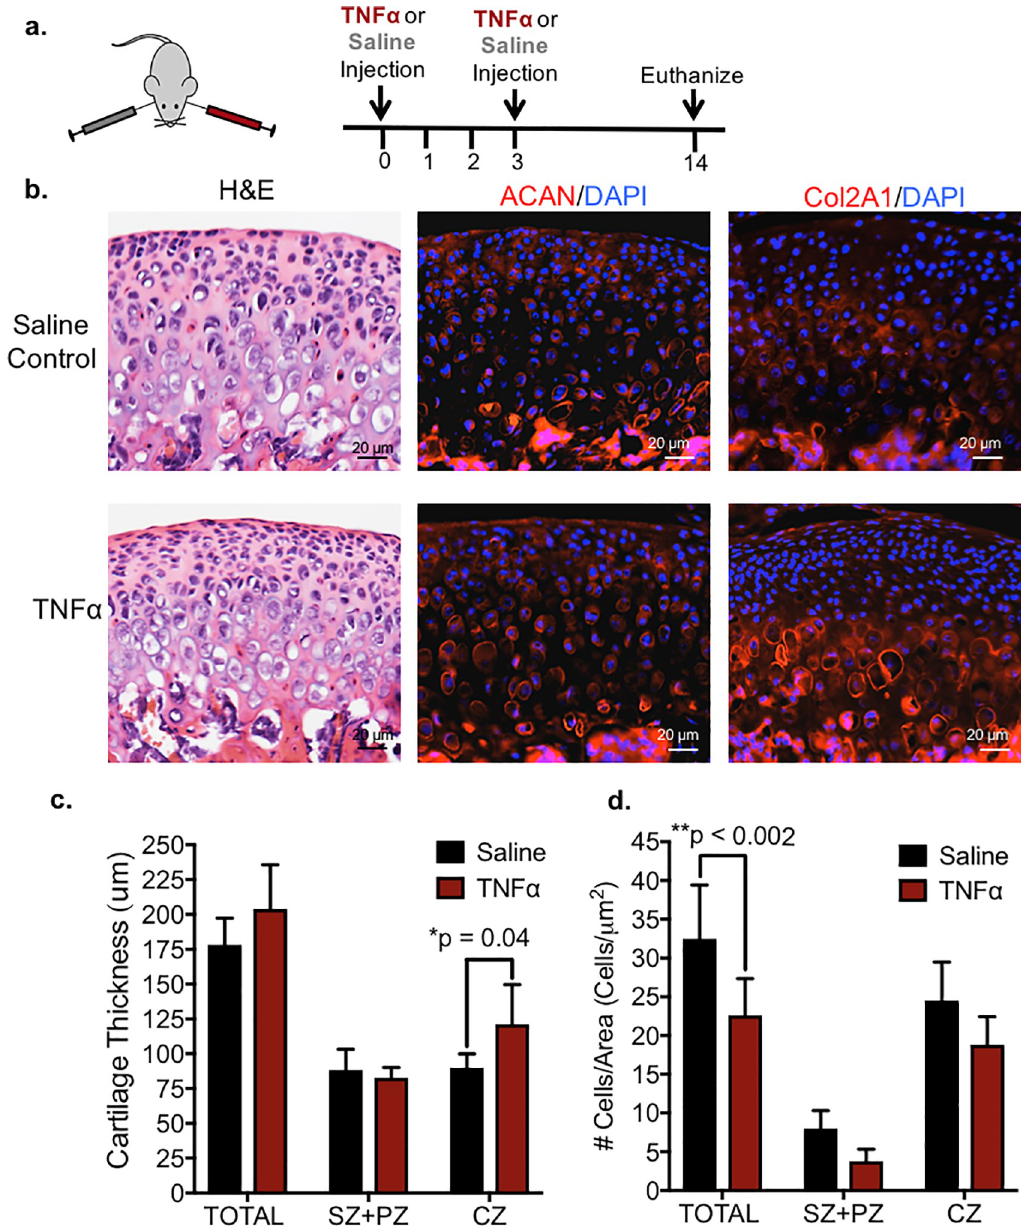
Fig 3. TMJ intra-articular injections of rhTNF-alpha promotes increased cartilage thickness and cell depletion in mandibular condyles. (a) rhTNF-alpha was injected intra-articularly into the TMJ unilaterally, while vehicle control was injected into the contralateral TMJ (n = 6 mice). (b) Representative and comparable histological sections from TMJs were stained with H&E. Immunohistochemistry (red) showed increase in aggrecan (ACAN) and type II collagen (COL2a1) expression in condyles treated with rhTNF-alpha. Isotype-matched negative control antibodies were used under the same conditions. (c) TMJs treated with rhTNF-alpha had significantly increased total cartilage thickness which was contributed to the expansion of the chondrocyte zone (CZ) as indicated by COL2a1+ expression relative to vehicle control explants. The superficial zone (SZ) and polymorphic zone (PZ) as indicated by COL2a1 - expression was not changed. Data are mean ± SD; n = 6 mice; two-way ANOVA followed by Tukey’s post hoc. (d) TMJs treated with rhTNF-alpha had significantly decreased number of cells within chondrocyte zone (CZ) and superficial and polymorphic zones (SZ+PZ) as indicated by COL2a1 + and COL2a1 - expression respectively relative to contralateral TMJs. Data are mean ± SD; n = 6 mice; two-way ANOVA followed by Tukey’s post hoc.